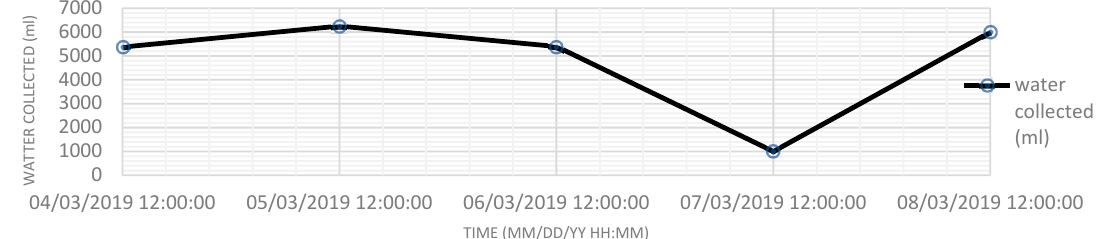
Figure 10. Total collected water from SS and HDH in the first week.